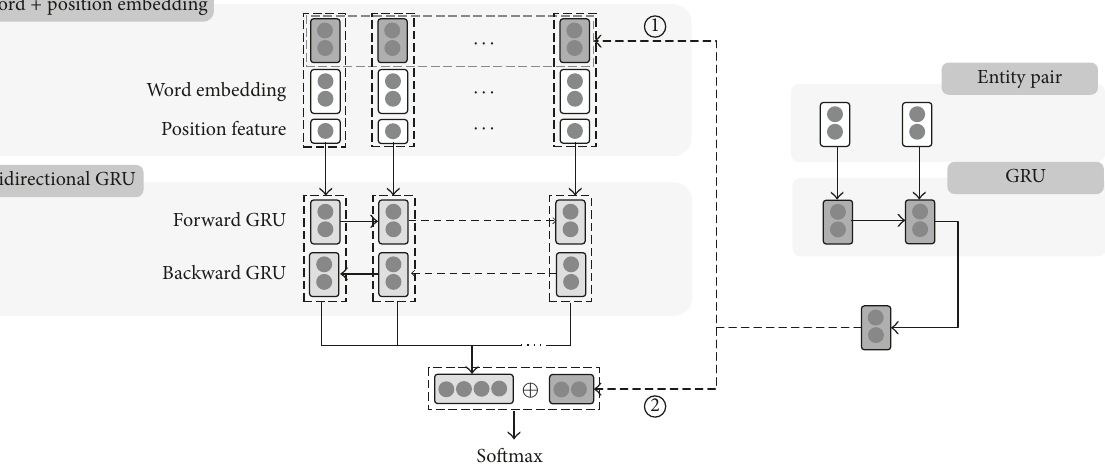
Figure 1: The structure of concatenation operation. As showed above, two substrategies are applied. With the obtained high-level entity pair embedding, substrategy A concatenates it with word embedding and position embedding; substrategy B adopts concatenation operation between sentence level embedding and entity pair embedding, where the compositional embedding is directly used to classify relation